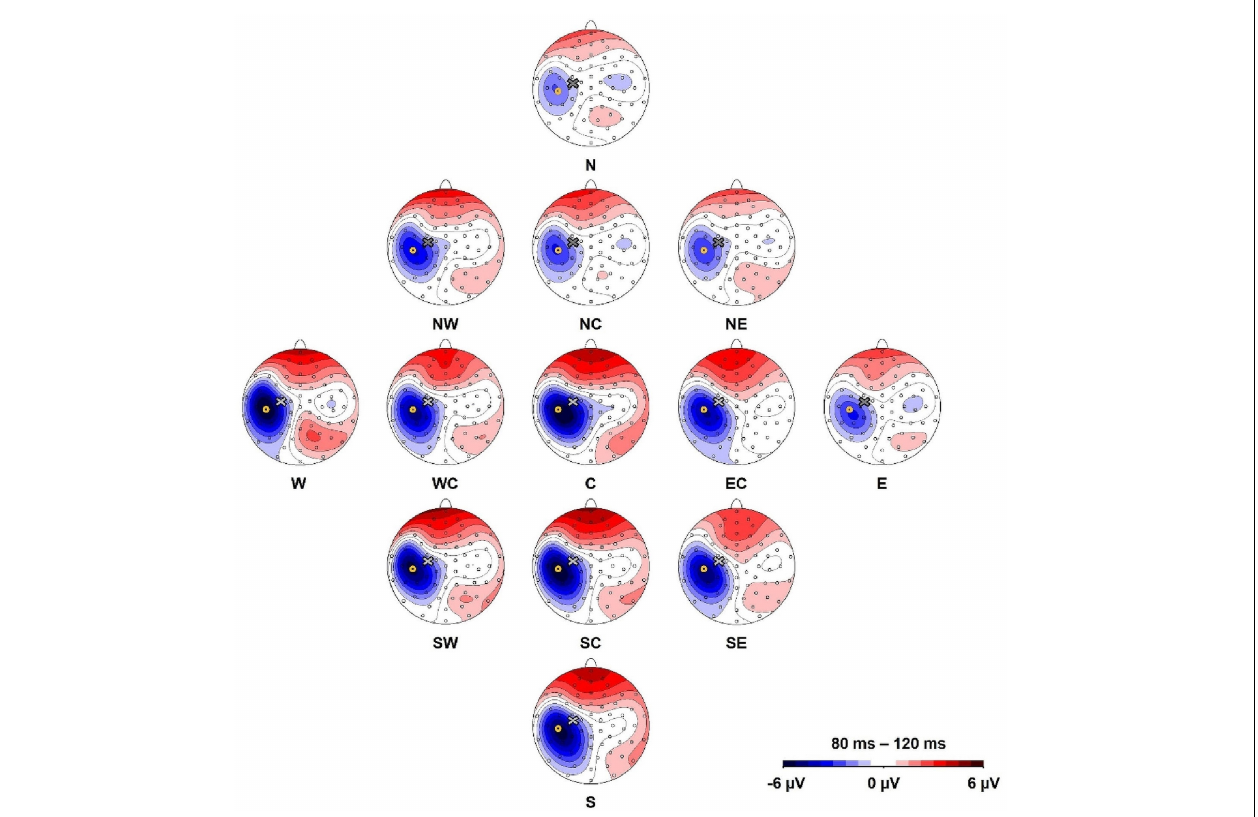
FIGURE 2 | Topography of the N100 component for all stimulation conditions (North, North-West, North-East, North-Central, Central, East-Central, East, South-East, South, South-Central, South-West, West, West-Central). Yellow circles mark the position of electrode C5 and the cross marks the approximate TMS stimulation site during hot spot stimulation (group average). The view is from the top of the head with the nose pointing